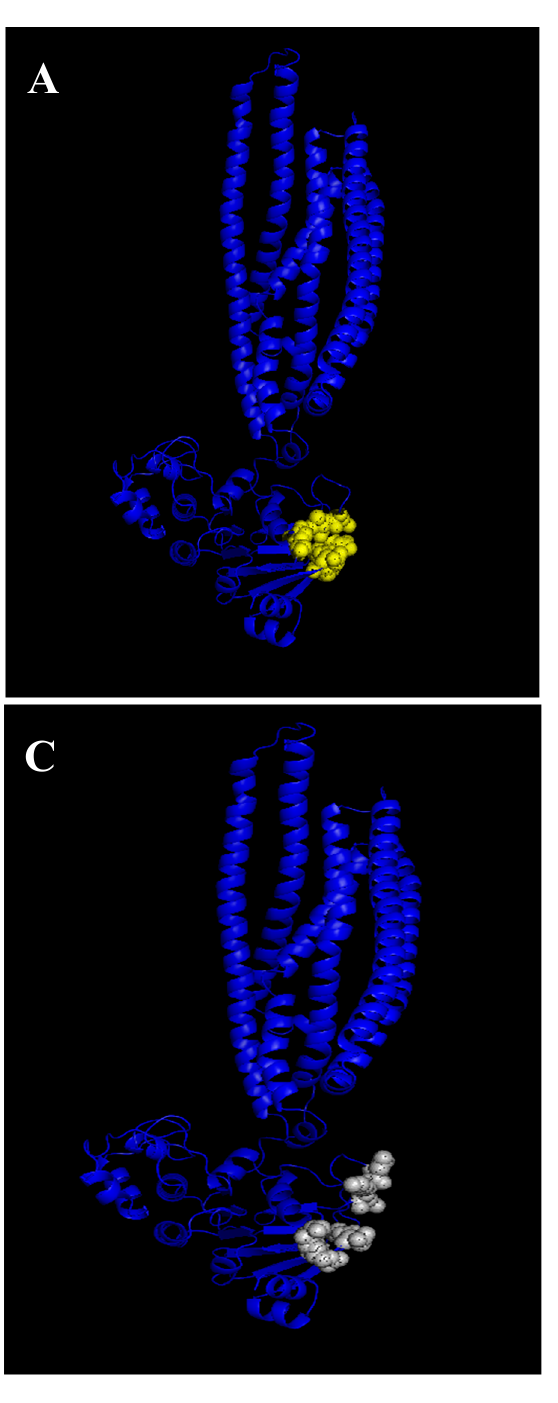
Figure 6. Molecular modelization and docking analysis of protein MsbA interactions with verapamil and novobiocine. ( A ) shows the modeled interactions of the MsbA ABC transporter with verapamil; ( B ) shows in green dotted lines the amino acids involved in the interaction of MsbA with verapamil; ( C ) shows the modeled interactions of the MsbA ABC transporter with novobiocin; and ( D ) shows in green dotted lines the amino acids involved in the interaction of MsbA with novobiocine.